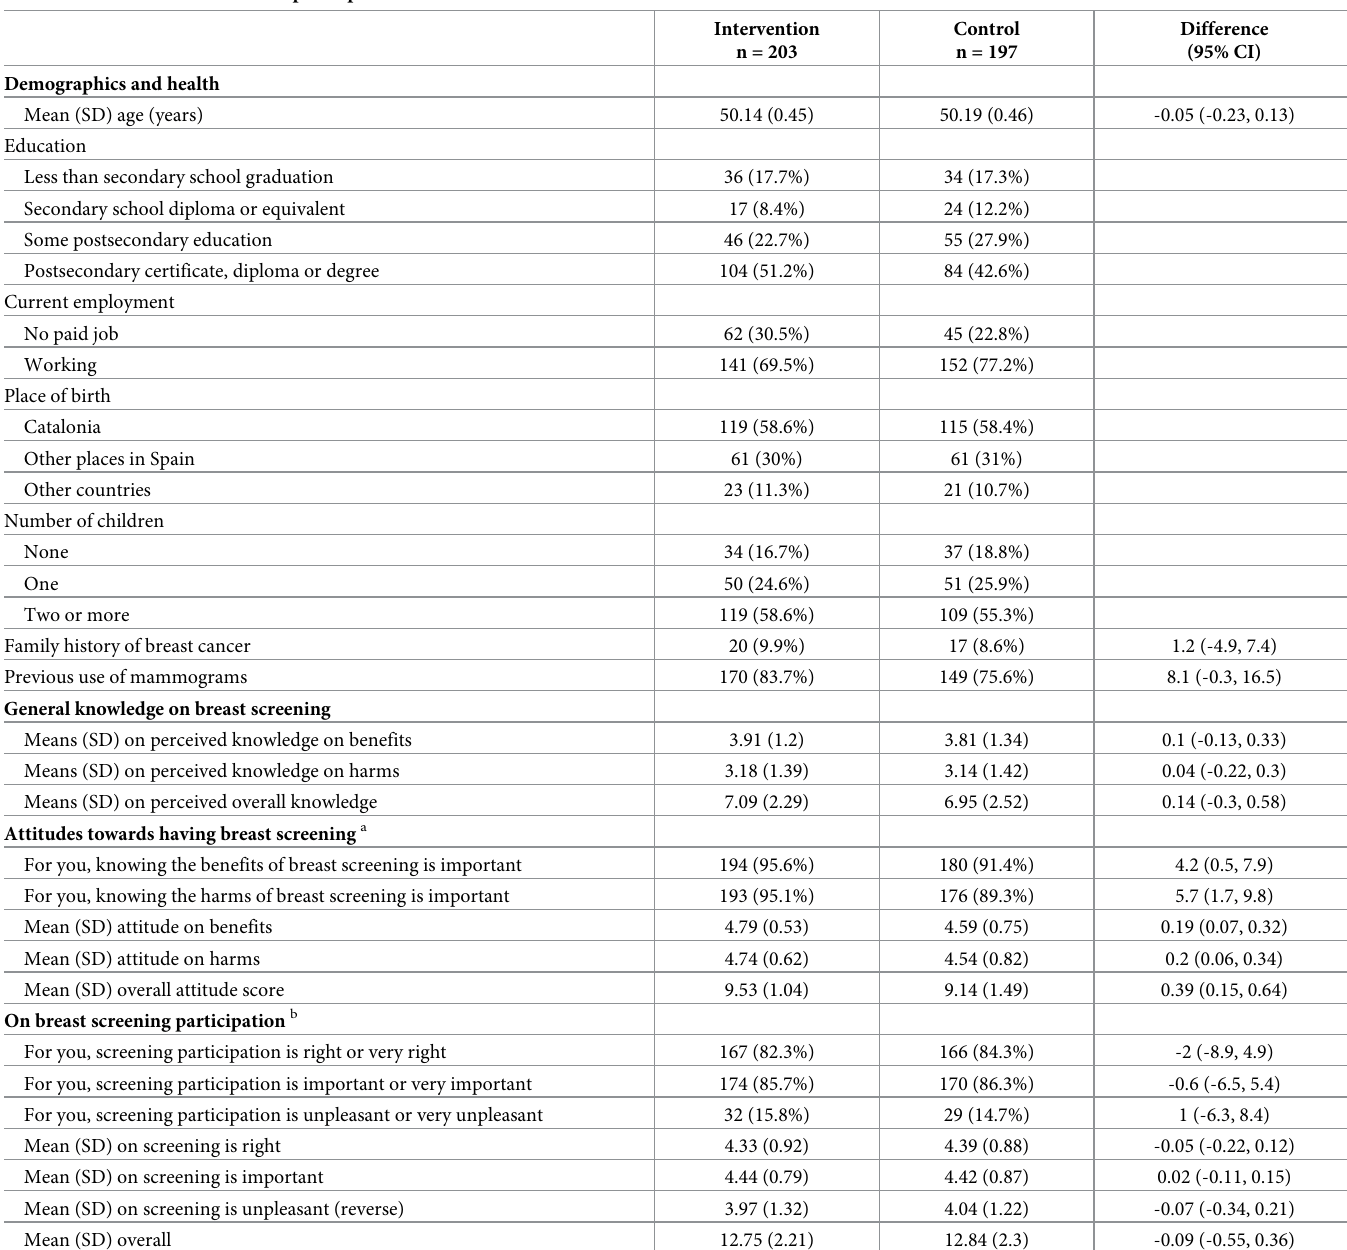
Table 1. Baseline characteristics of